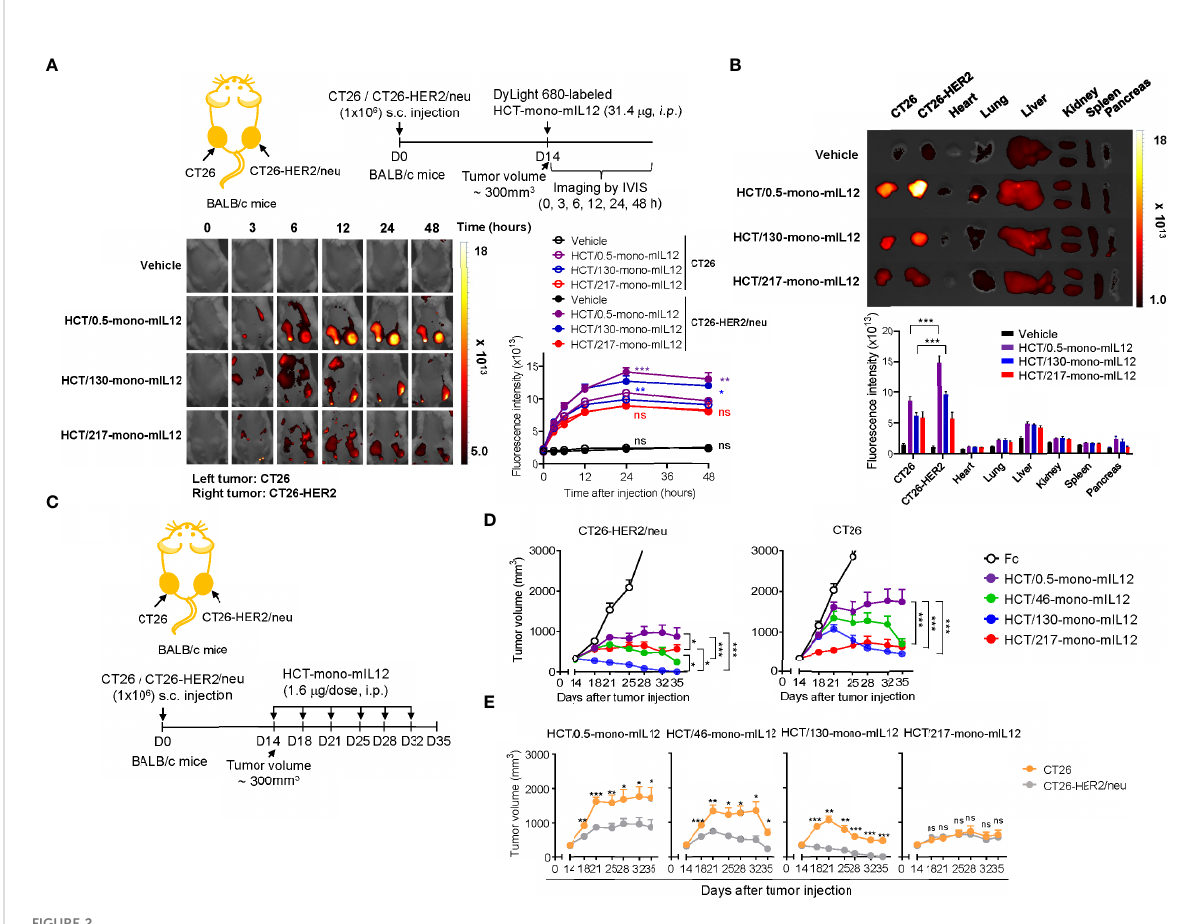
FIGURE 2 Selective tumor accumulation and antitumor activity of HCT-mono-mIL12 requires anti-HER2 af fi nity above a certain threshold. (A) Representative whole-body fl uorescence images showing the biodistribution of DyLight 680-labeled HCT-mono-mIL12 according to the indicated time after a single i.p. injection of 31.4 m g into BALB/c mice bearing dual- fl ank tumors of CT26 (left fl ank) and CT26-HER2/neu (right fl ank) cells assessed at a tumor volume of ~300 mm 3 ; additional images are shown in Supplementary Figure 2A. Right , fl uorescence intensities in CT26 and CT26-HER2/neu tumor tissues, quanti fi ed by radiant ef fi ciency. Data represent means ± SEM (n = 7). *p < 0.05, **p < 0.01, ***p < 0.001 between CT26 and CT26-HER2/neu tumors; ns, not signi fi cant. (B) Ex vivo analysis of fl uorescence intensity of the excised tumors and normal organs 48 h after a single i.p. injection of DyLight 680-labeled HCT-mono-mIL12, as shown in (A) . Tumor tissue and normal organs of one representative mouse from each group are shown; additional images are shown in Supplementary Figure 2B. Lower , fl uorescence intensities of tumors and organs quanti fi ed by radiant ef fi ciency. In (A, B) , vehicle indicates PBS buffer as control. Data represent means ± SEM (n = 7). *** p < 0.001 between the indicated groups. (C – E) Treatment scheme of BALB/c mice bearing dual- fl ank tumors of CT26 (left fl ank) and CT26-HER2/neu (right fl ank) cells initiated at a tumor volume of ~300 mm 3 with i.p. injection of HCT-mono-mIL12 at 1.6 m g per dose (an equimolar amount of 0.5 m g rmIL12 per dose) twice weekly (C) to determine the antitumor ef fi cacy (D, E) . In (D, E) , the growth of CT26 and CT26-HER2/neu tumors, measured by tumor volume, is shown separately (D) or comparatively (E) according to HCT-mono-mIL12. Data represent means ± SEM (n = 12 – 14 per group). *p < 0.05, **p < 0.05, ***p < 0.001 between the indicated groups (D) and between CT26 and CT26-HER2/neu tumors; ns, not signi fi cant (E) . Data are pooled from two independent experiments with at least four mice per